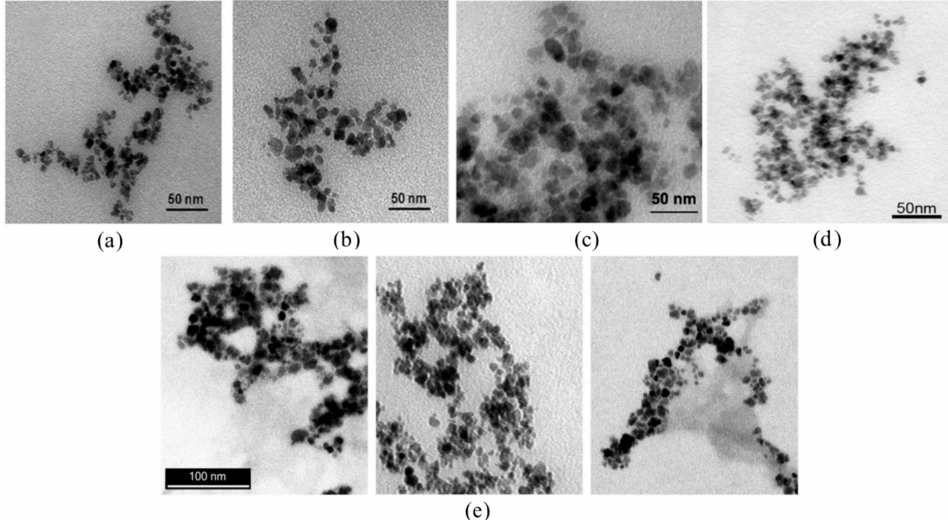
Figure 4. TEM images of di ff erent ultrasmall superparamagnetic iron oxide (USPIO) formulations: ( a ) USPIO; ( b ) FMN USPIO; ( c ) FAD USPIO; ( d ) and ( e ) di ff erent absorptive coating FMN USPIO: ( d ) GMP-FMN USPIO; ( e ) AMP-FMN USPIO, ADP-FMN USPIO, and ATP-FMN USPIO (left to right); Adapted with permission from